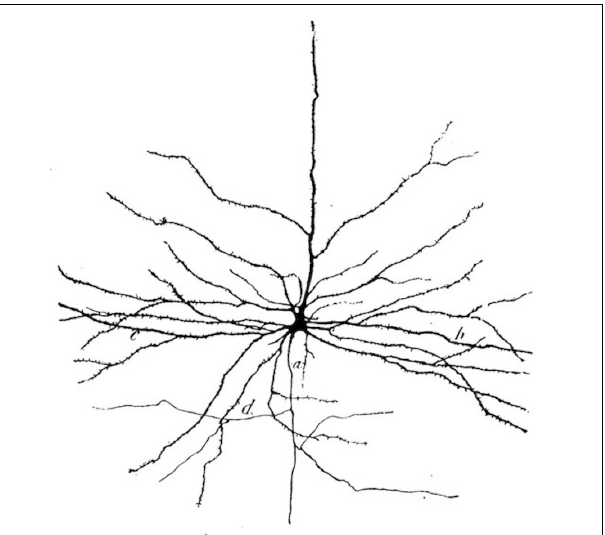
FIGURE 3 | Cajal’s illustration of a giant pyramidal neuron in a 30-year-old male, as it appears in his textbook. Digital reproduction of Figure 690 in Santiago Ramón y Cajal, Textura del sistema nervioso del hombre y los vertebrados , Volume 2, Pt. 2 (Imprenta y librería de Nicolás Moya, Madrid, 1904), 838. Available at http://www.google.com/books/edition/_/AUlQA